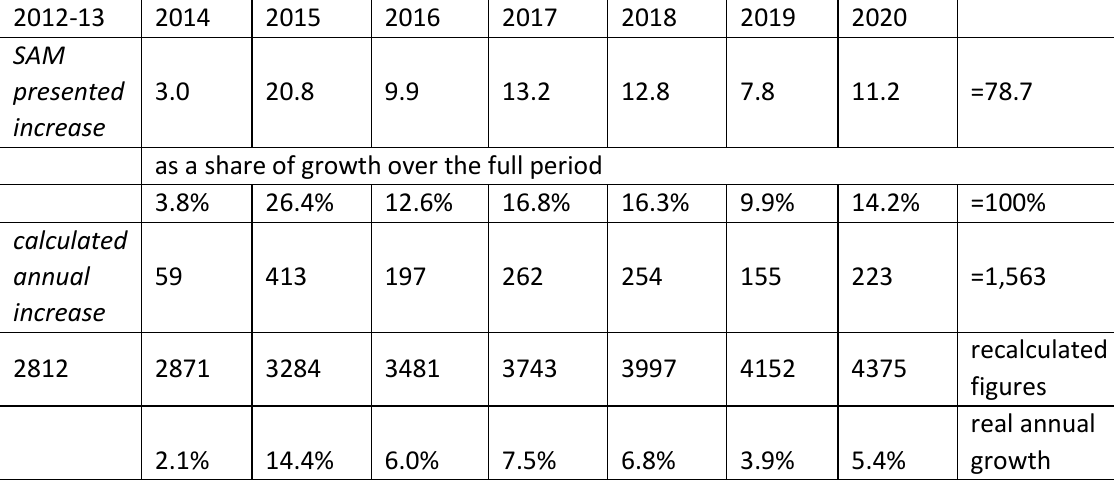
Table 7: Recalculated Figures – Employment in Commercial Archaeology